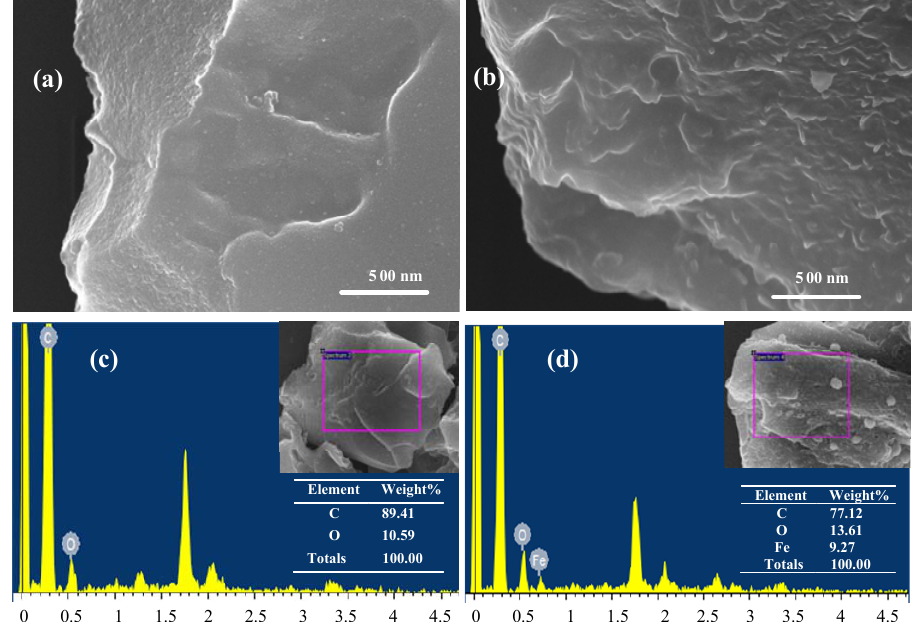
Figure 1. Scanning electron microscope (SEM) images ( a , b ) and energy-dispersive X-ray (EDX) spectra ( c , d ) for spent coffee grounds (SCG) (left) and Fe-SCG (right). The Fourier transform-infrared (FTIR) spectra of the SCG and Fe-SCG are displayed in Figure 2a. The band intensities of C–H stretching of aliphatic groups (3000–2800 cm − 1 ) were observed in both the SCG and Fe-SCG. The reductions of the bands for the bending mode of adsorbed water (1627 cm − 1 ), C-C aromatic (1384 cm − 1 ) and aromatic CO-stretching guaiacyl ring in lignin and RCO-O